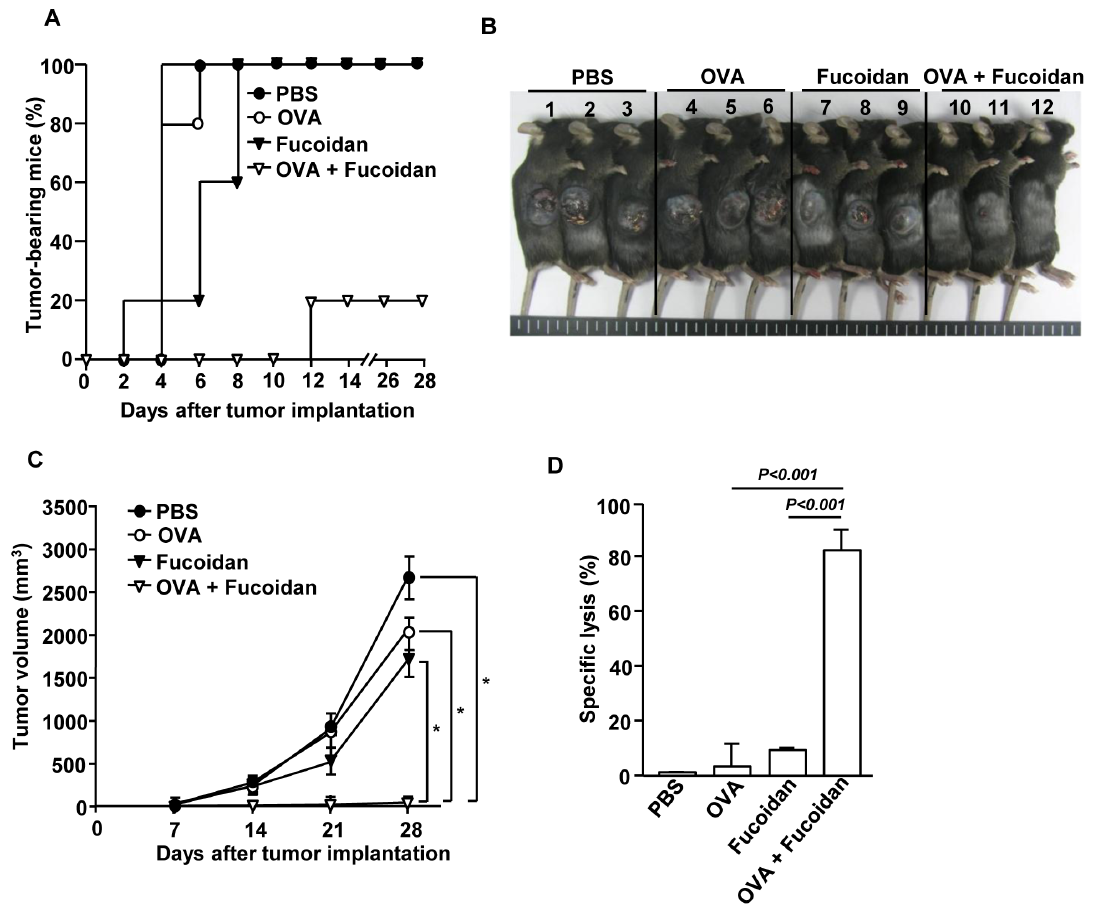
Figure 6. Immunization with OVA and fucoidan protects mice from challenge with B16-OVA tumor cells. C57BL/6 mice were immunized with PBS, OVA, fucoidan or OVA + fucoidan on days 0, 15 and 30. On day 35 of immunization, the mice were challenged s.c . with 1 6 10 6 B16-OVA (melanoma) tumor cells. (A) The percentage of tumor-bearing mice and (B) the picture of tumor bearing mice are shown. (C) Tumor growth curves are shown. All data are representative of or the average of analyses of 5 independent samples (2 or 3 mice per experiment, total 2 independent experiments). *, statistically significant values, defined as P , 0.01 and determined with paired Student’s t test, compared with corresponding groups. (D) On day 35, in vivo killing of adoptively transferred SIINFEK-coated and CFSE-labeled target cells by CTLs in the immunized mice was measured. Data are from analyses of 6 individual mice each group (2 mice per experiment, total 6 independent experiments).